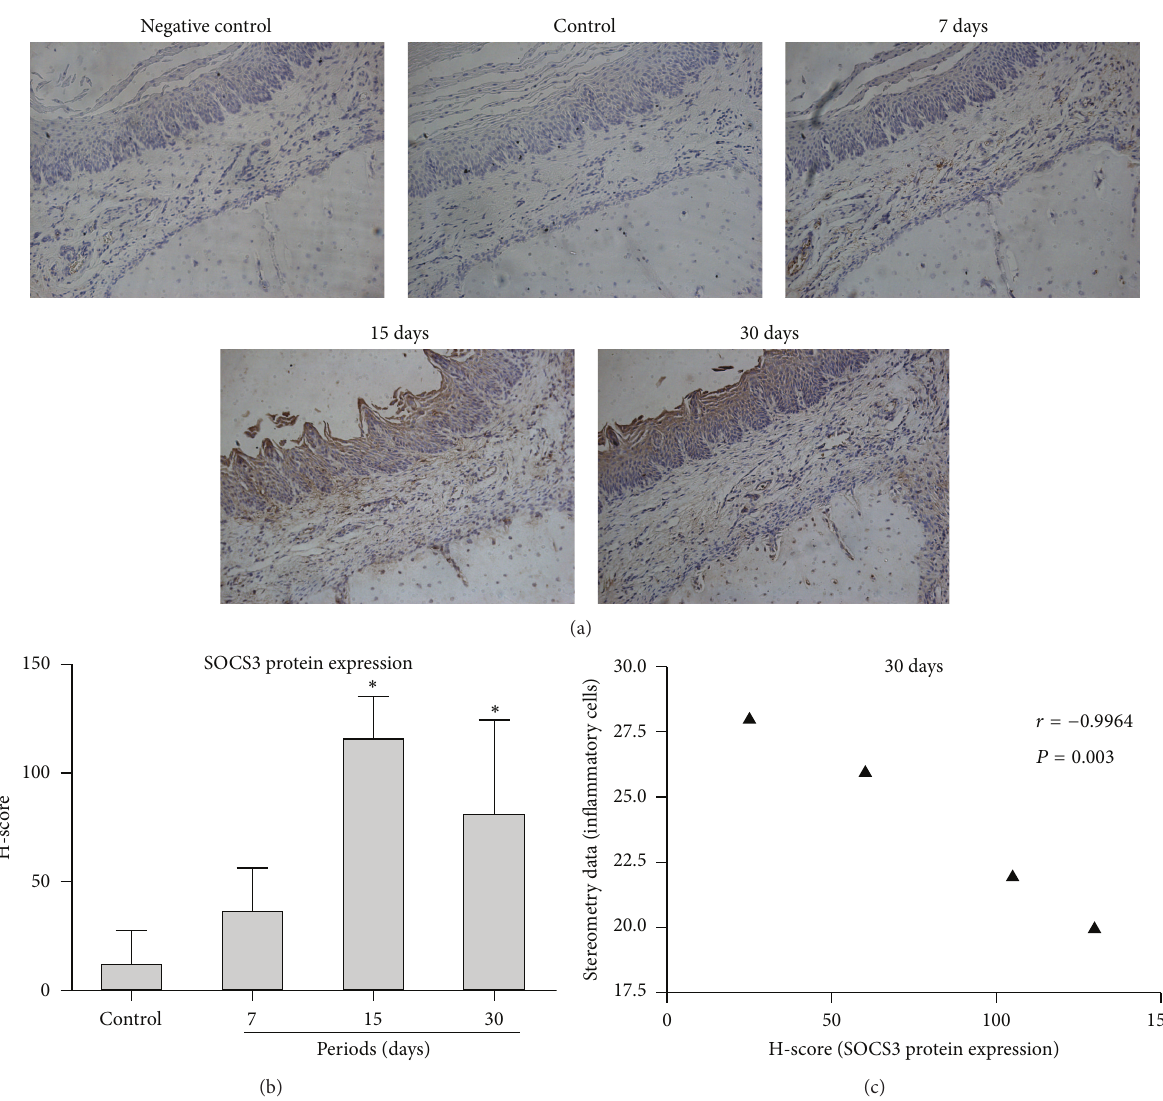
Figure 4: Immunohistochemical analysis revealed an increased number of SOCS3-positive cells after 7, 15, and 30 days after LPS injection. This increase reached statistical significance in comparison with gingival tissues of the control group at 15 and 30 days, as indicated by H-score analysis. Note that SOCS3-positive cells were located primarily near blood vessels and on the surface of alveolar bone. ∗ Significant differences compared with control groups ( 𝑃 < 0.05